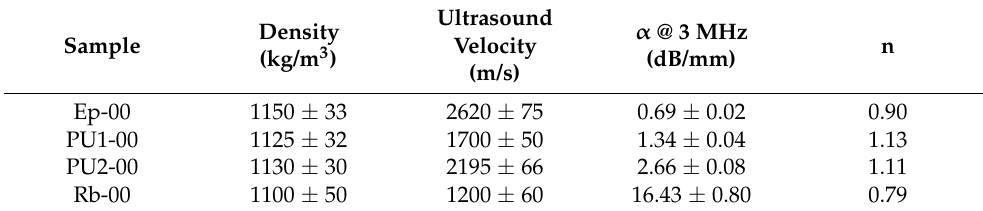
Table 3. Ultrasonic properties of the raw materials.